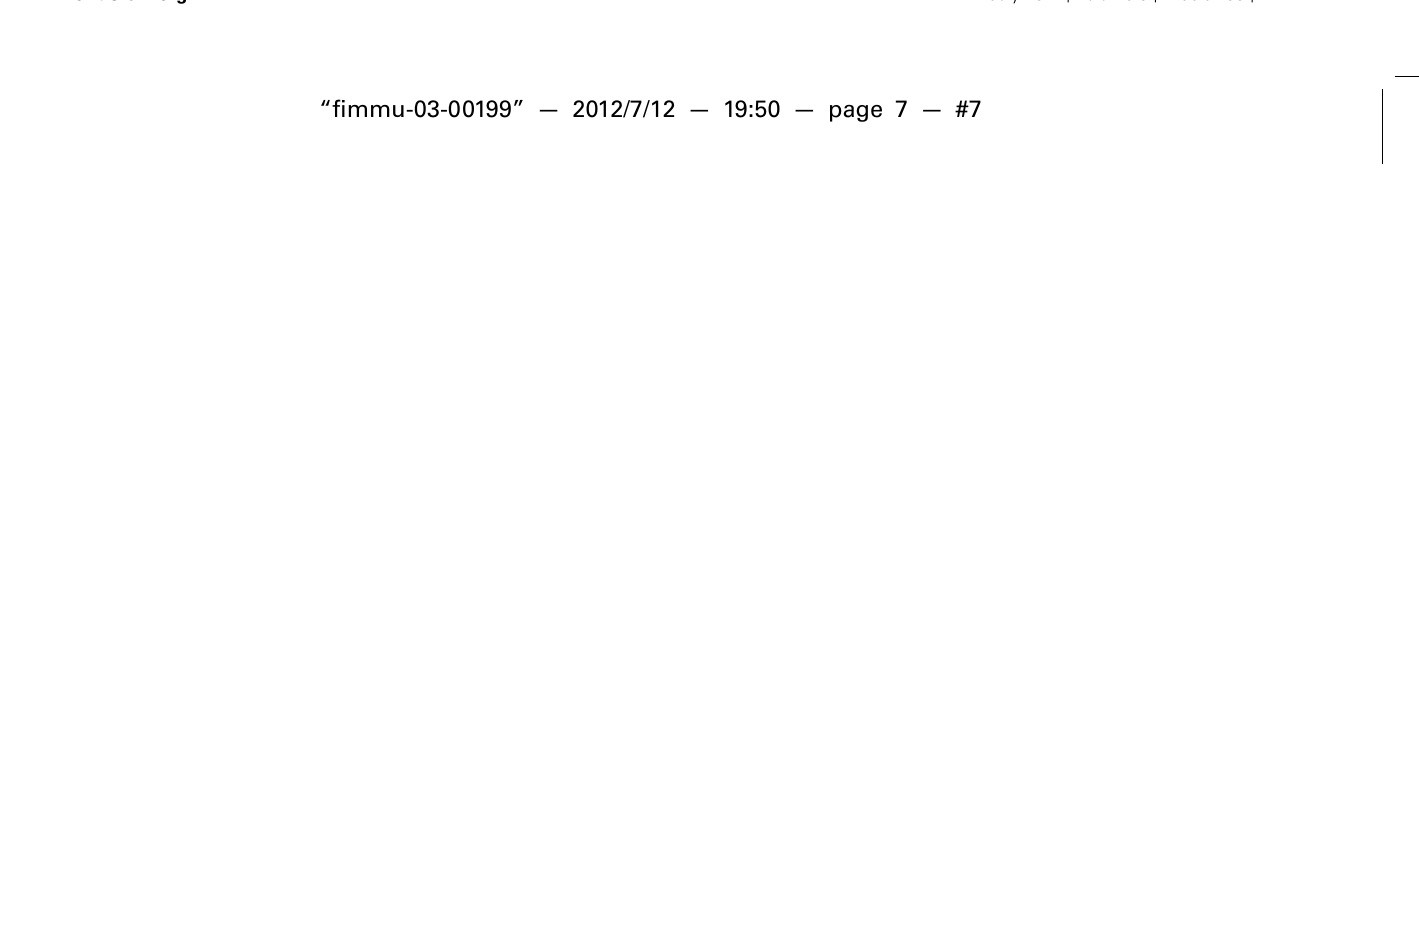
cell surface glycans (5) , and cross-link them with ECM glycans (6) thereby, for example, promoting cell migration. Galectins can also cross-link cell surface glycans and induce clustering of microdomains and lattice formation at the cell surface (7) that can trigger signaling cascades, or cross-link neighboring cells (8) and promote cell–cell interactions/